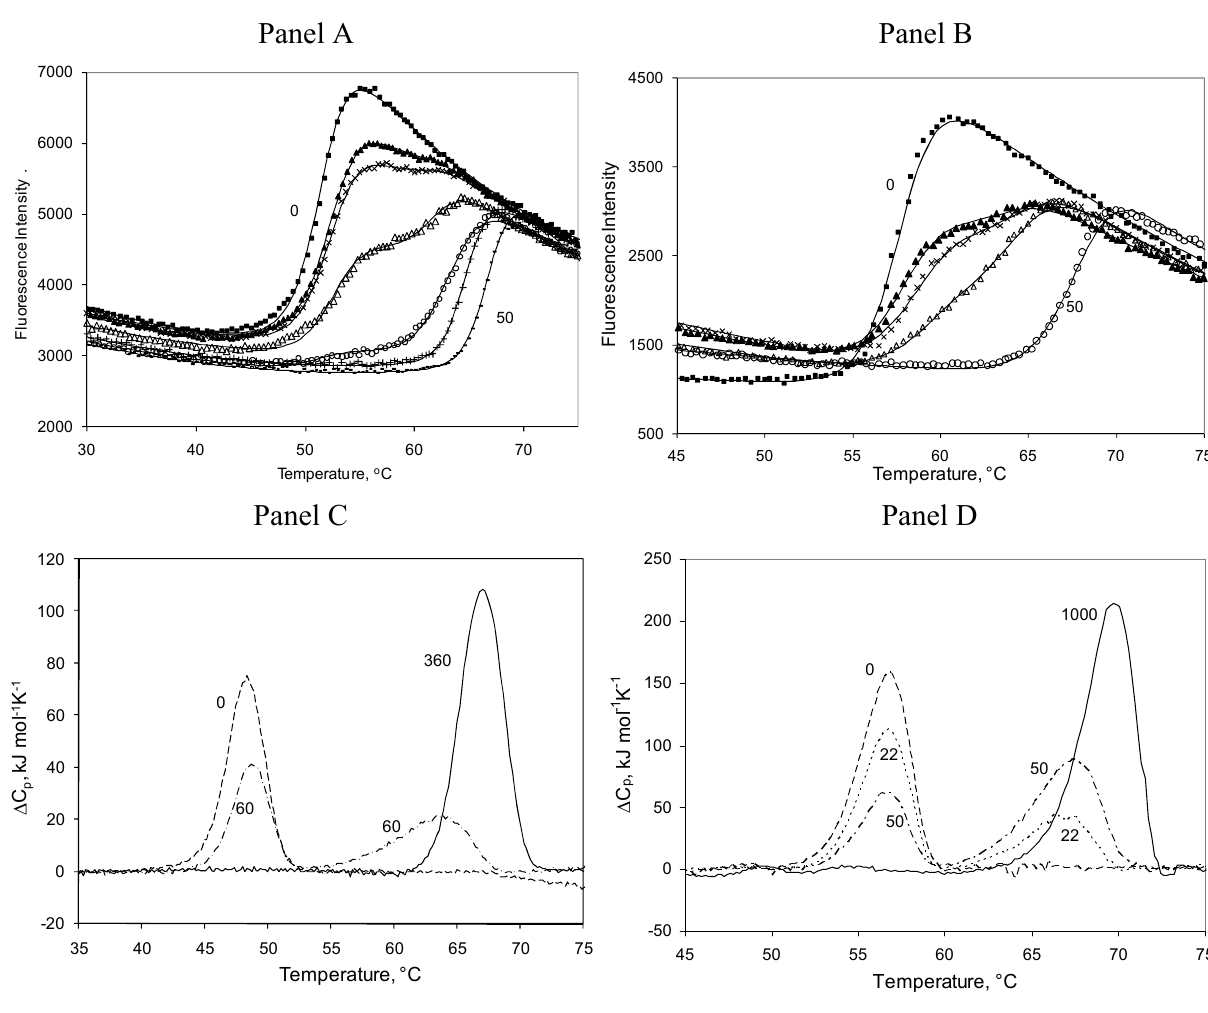
Figure 2. Denaturation profiles of Hsp90 α N or hCAII in the presence of inhibitors. Panel A. Hsp90 α N (14 µM) in 50 mM Tris buffer, pH 7.5, with added radicicol: (cid:132) - 0 µM, (cid:24) - - 2 µM, × - 3 µM, Δ - 6 µM, (cid:123) - 10 µM , + - 20 µM, and - 50 µM. Panel B. hCAII (5 µM) in 50 mM phosphate buffer, pH 7.0, containing 50 mM NaCl, with added ethoxzolamide: (cid:132) - 0 µM, (cid:24) - 1.5 µM, × - 2 µM, Δ - 3 µM, and (cid:123) - 50 µM. Increased inhibitor concentrations raise the melting temperature of both proteins by more than 10 ºC, depending on concentration. Two transitions are observed when both free and ligand- bound proteins are present. Heights of both transitions are additive and proportional to the fraction of saturation by the inhibitor. The data points represent experimental observations while the lines are fit to Equation (10). Parameters are listed in Table 1. Panel C. DSC profiles of Hsp90 α N (120 µM) with radicicol: dashed line – 0 µM, dot-dashed line – 60 µM, and solid line – 360 µM. Panel D. DSC profiles of hCAII (100 µM) with ethoxzolamide: dashed line – 0 µM, dotted line – 22 µM, dot-dashed line – 50 µM, and solid line – 1 mM. Panel A Panel